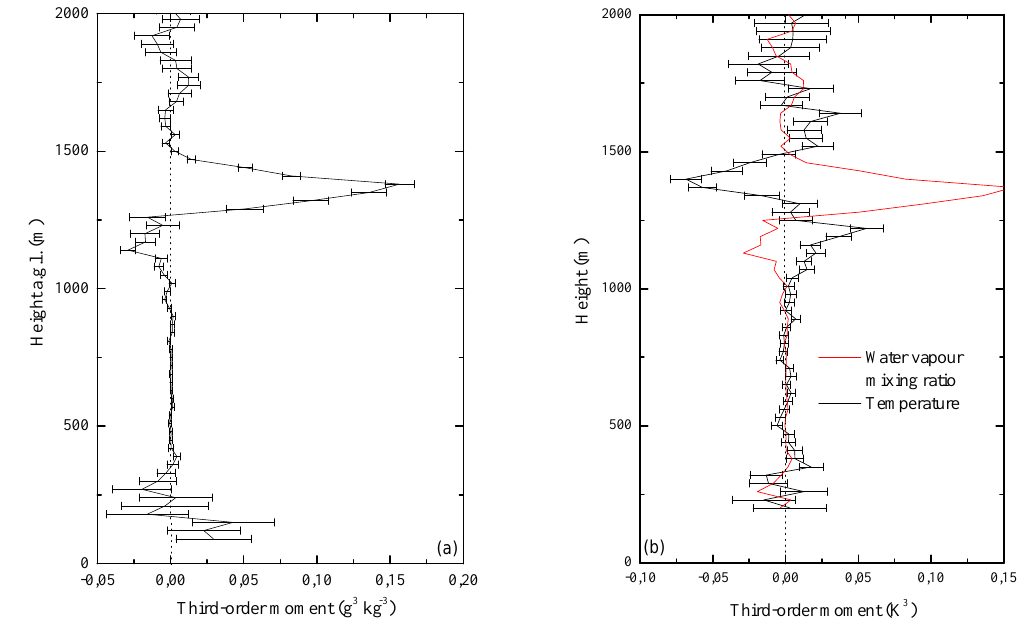
Figure 11. Vertical profiles of the third-order moment for water vapour mixing ratio (a) and temperature (b) computed for the same time interval considered in Fig. 4. In the figure the error bars represent only the noise